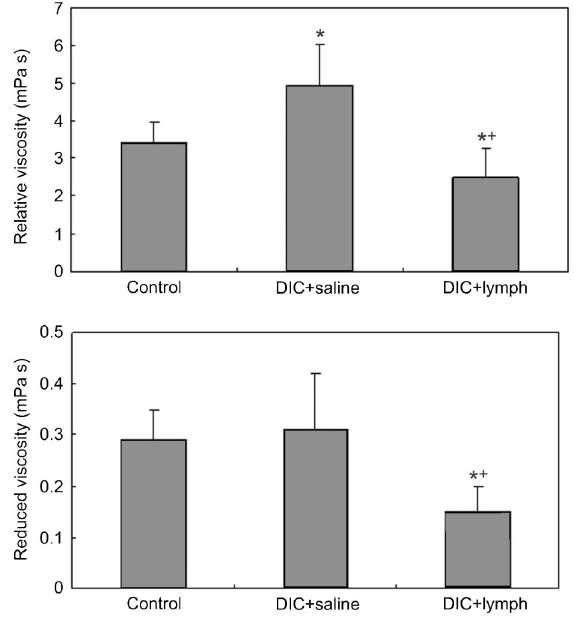
Figure 6. Changes of relative viscosity and reduced viscosity in the three rat groups studied. Data are reported as means ± SD in mPa s for 10 rats. *P , 0.05 compared to the control group; + P , 0.05 compared to the DIC + saline group (one-way